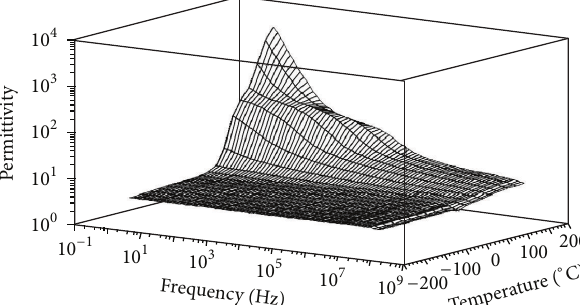
Figure 6: Dependence of the permittivity of the epoxy polymer without any filler from the temperature in the frequency range 1Hz–